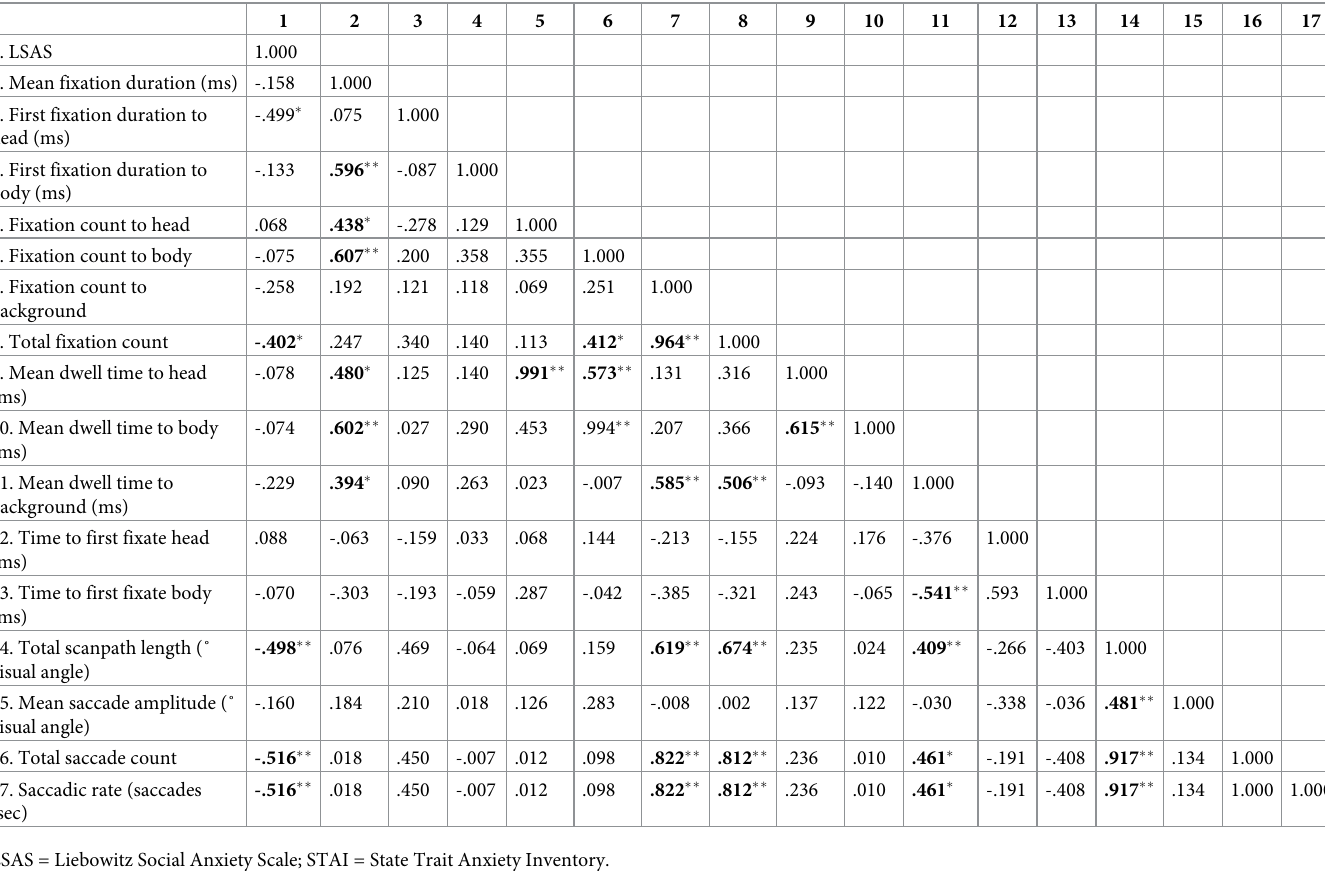
Table 3. Partial correlation matrix, controlling for state social anxiety scores from STAI for all eye movement measures against LSAS